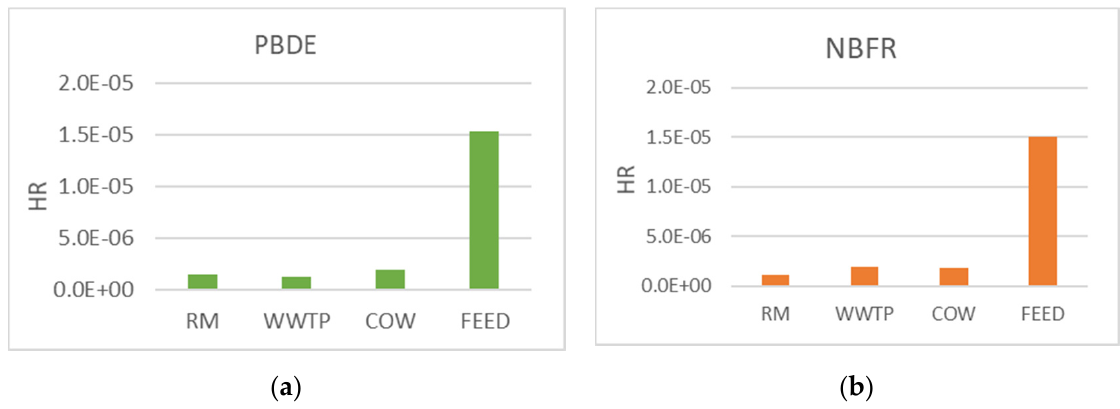
Figure 14. Non-carcinogenic risk due to PM10 bound PBDE ( a ) and NBFR ( b ) in all the monitoring sites.